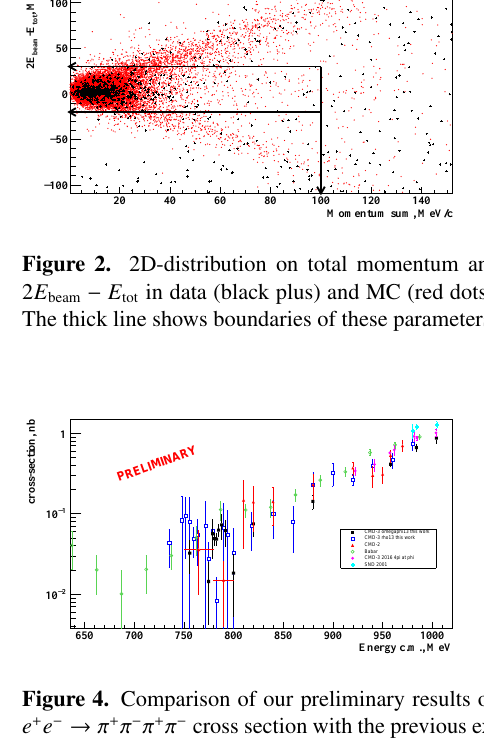
Figure 3. Energy dependence of the detection e ffi - ciency